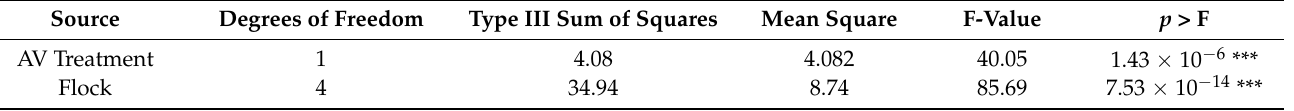
Table 6. Results of analysis of covariance test for differences in surface temperature under AV treatment.